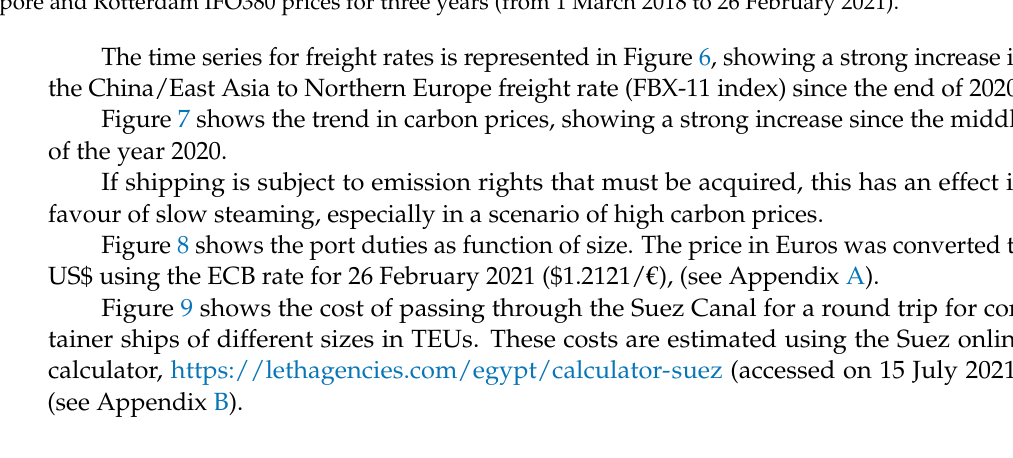
Figure 5. Singapore and Rotterdam IFO380 prices for three years (from 1 March 2018 to 26 February